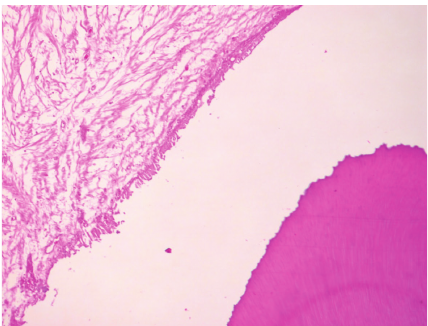
Figure 5: Histological section showing enamel space, scalloped dentinoenamel junction, dentinal tubules, and follicular tissue (objective 20x).